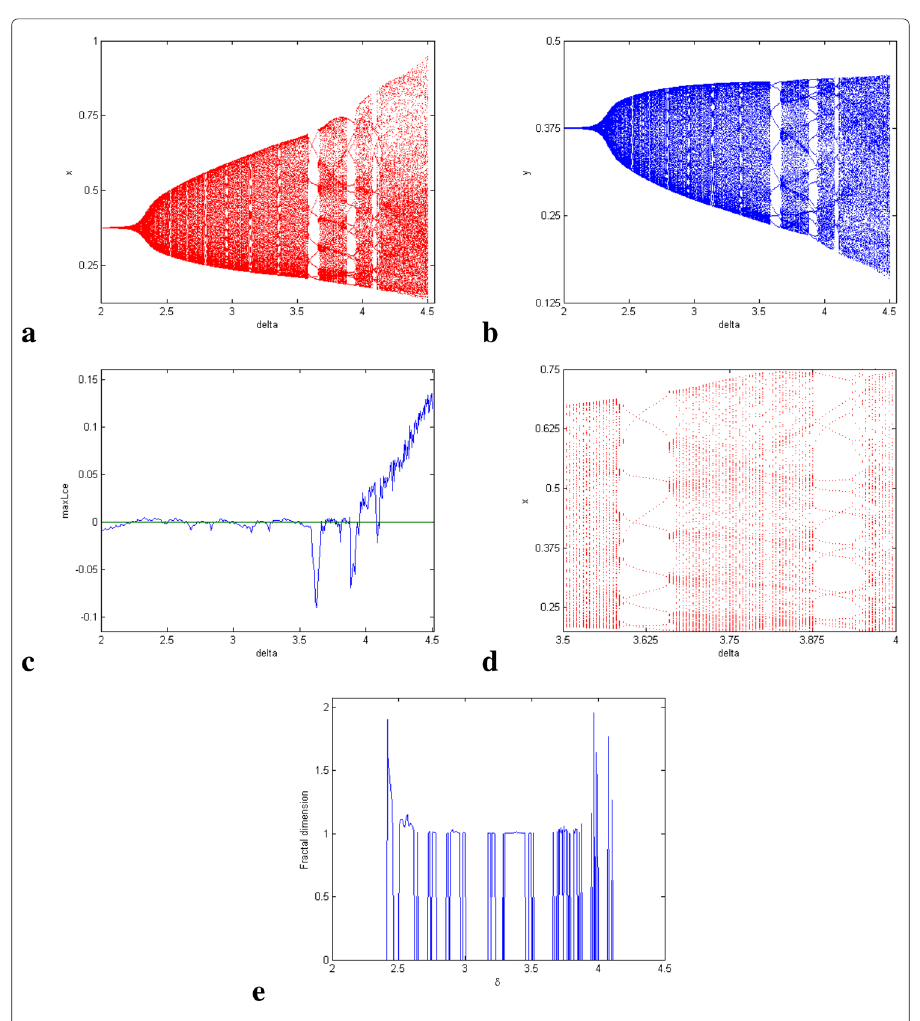
Fig. 2 NS bifurcation of system (3). a NS bifurcation in prey, b NS bifurcation in predator, c maximum Lyapunov exponents corresponding to a , b . d Local amplification diagram in a for δ ∈ [3.5,4.0]. e FD associated with a . ( x 0 , y 0 ) = ( 0.37,0.37